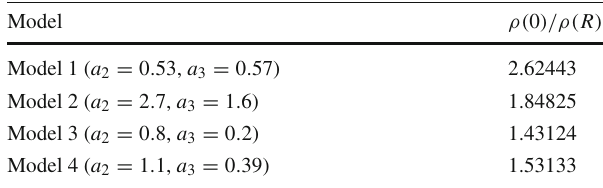
Fig. 11 Z for Model 1 ( a ), Model 2 ( b ), Model 3 ( c ) and Model 4 ( d ) Table 2 Estimated values of the density ratio for SMC X-1 (u = 0.19803)